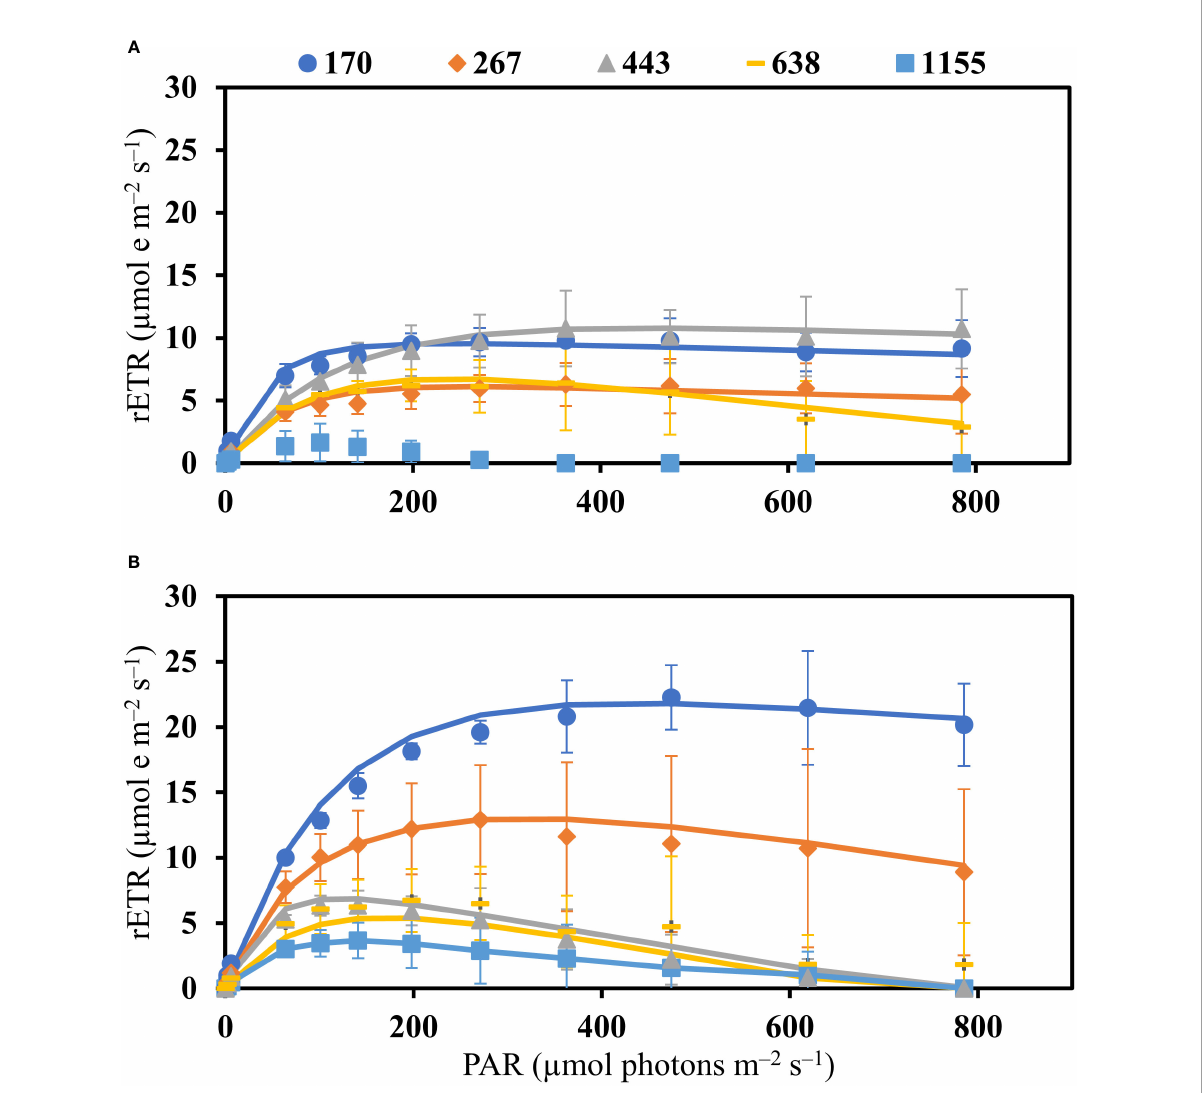
FIGURE 3 Relative electron transport rate (rETR) vs. photon fl uence rate (PAR) curves of Bostrychia calliptera (A) and B. montagnei (B) cultured under different photon fl ux densities (PFDs: 170, 267, 443, 638, and 1155 µmol photons m – 2 s – 1 ) for 14 days. Symbols are means with standard deviations (bars) based on four replicates ( n = 4). Lines are rETR vs. PAR curves fi tted by applying the mathematical model of Walsby